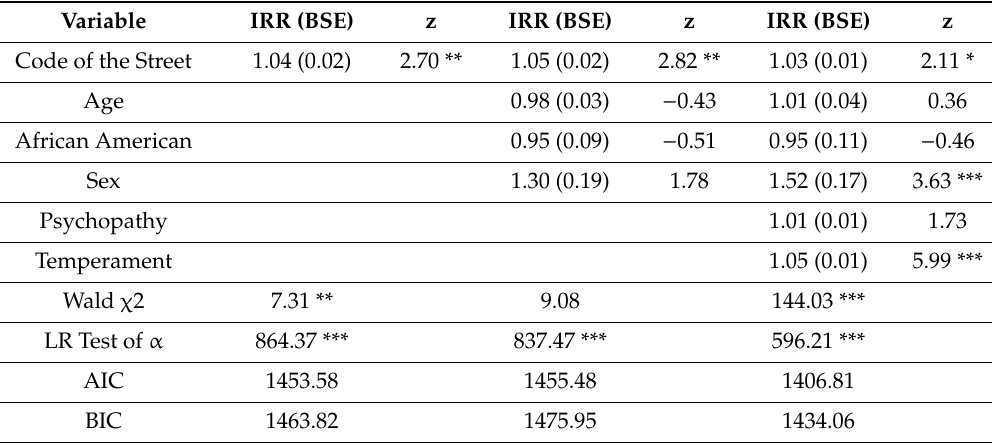
Table 3. Negative binomial regression models for self-reported violence.